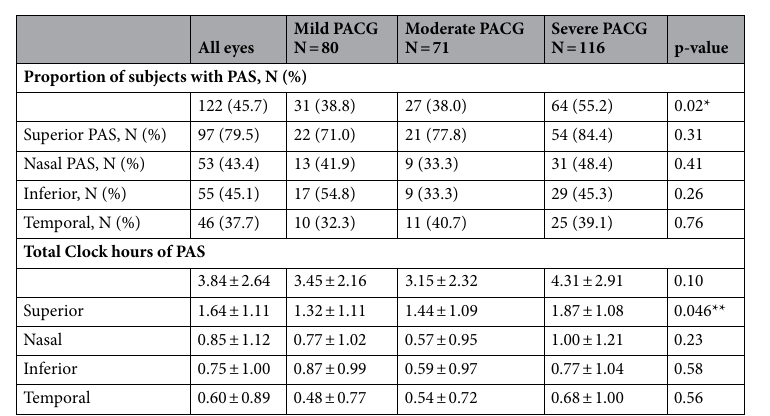
Table 2. Distribution and extent of PAS across PACG disease severity (N = 267). PAS peripheral anterior synechiae, PACG primary angle closure glaucoma. *Mild vs Severe PACG and Moderate vs Severe PACG = 0.02. **Mild vs Severe PACG =